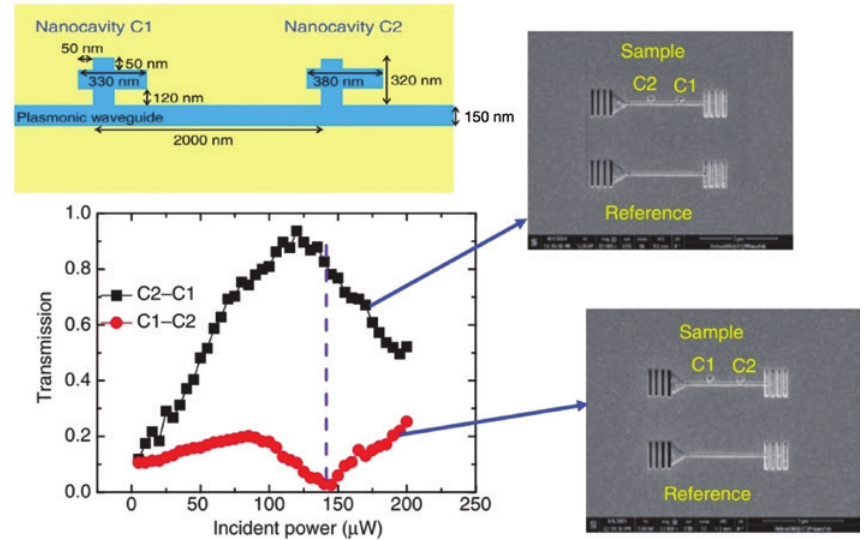
Figure 7: Schematic and experimental results of the all-optical diode based on PIT nanocavities system combined with nonlinear materials. The device is composed of two cross-shaped plasmonic nanocavities with a slight difference. The operating wavelength is 795 nm and the measured all-optical diode performance is also shown [154]. Reproduced with permission from Ref. [154]. Copyright 2017 De